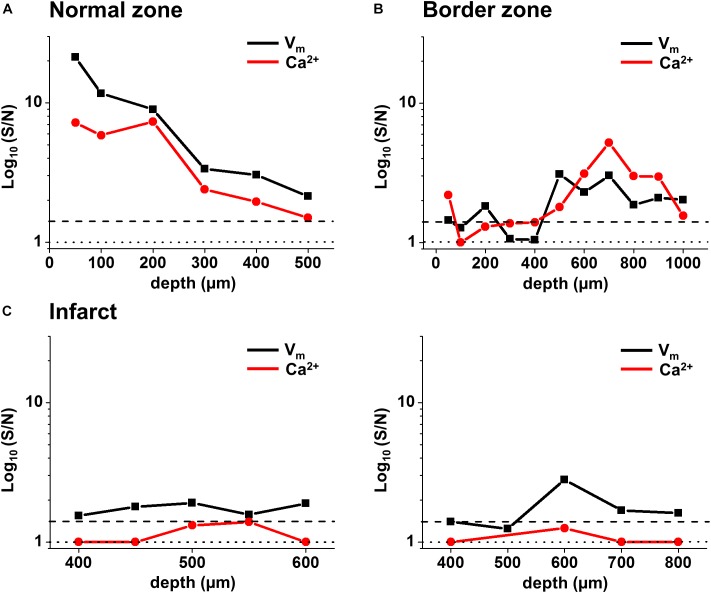
Voltage and Ca2+ signal-to-noise in the normal zone (NZ), border zone (BZ), and infarct zone (IZ) from individual hearts. Voltage (black) and Ca2+ (red) S/N were plotted through depth for individual hearts in (A) NZ, (B) BZ, and (C) IZ. S/N in the IZ for two hearts [left and right panels in (C)] were plotted between depths where a voltage signal was detected. S/N values of 1 (no distinguishable signal) are illustrated by the dotted line. S/N values of 1.4 (indicating a real signal) are illustrated by the dashed line.